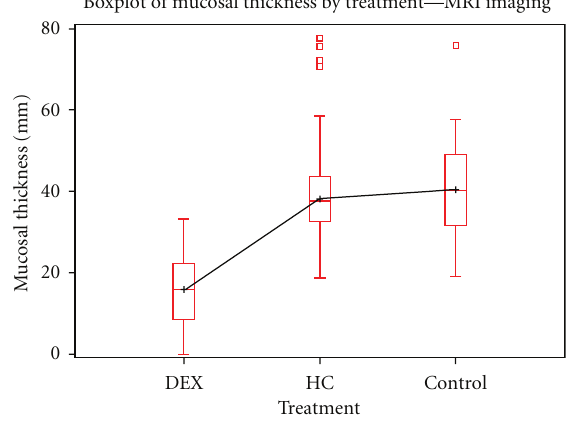
Figure 3: Boxplot of mucosal thickness by MRI Imaging. While there are some outliers present in the HC and control groups, the overall relationship of MT measures across treatment groups is statistically di ff erent, with DEX exhibiting significant MT reduction ( N = 380, α = 0 . 05, F = 146 . 0861, P -value < 0.0001). MRI MT measures were based in millimeters (mm). Table 2: Tukey’s followup analysis for Histology measures of MT. Histology confirmed MRI results for DEX e ffi cacy at reducing MT. Though HC was e ff ective at reducing MT when compared to control alone, the di ff erence was not statistically significant. Only DEX significantly reduced MT compared to both HC and control treatment groups. The di ff erences between means reported by histology are similar to those reported by MRI but seem smaller in magnitude. This may be attributed to histoprocesses that compromise tissue integrity (i.e., MT desiccation due to various chemical changes, other e ff ects on MT resulting from para ffi n impregnation, etc.). Di ff erences in histology and MRI findings could also result from a di ff erence in sample siza. N = 380 for MRI and N = 194 for histology. MT measures by Histology α = 0 .